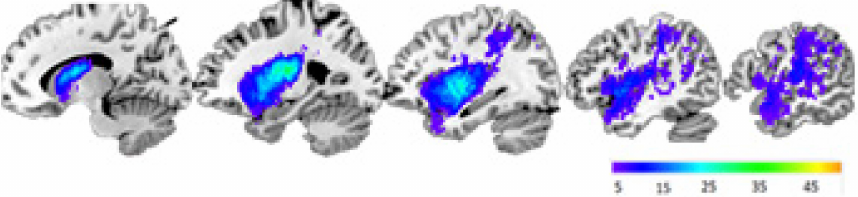
Figure 1. LHSP brain lesion: Overlap of the binarized lesions of the left-hemispheric stroke patients included in the study ( n = 49) in radiological convention mapped onto the Montreal Neurological Institute (MNI) template. Overlays are thresholded to show lesions present in at least 5 individuals as included in the lesion–symptom mapping analysis. The color bar indicates the degree of overlap of